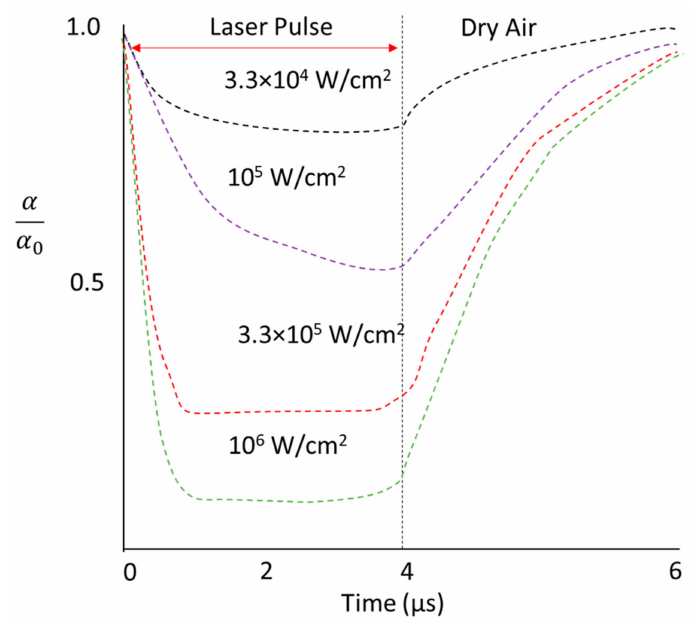
Figure 16. Absorption coefficient saturated by short pulses [28,47].